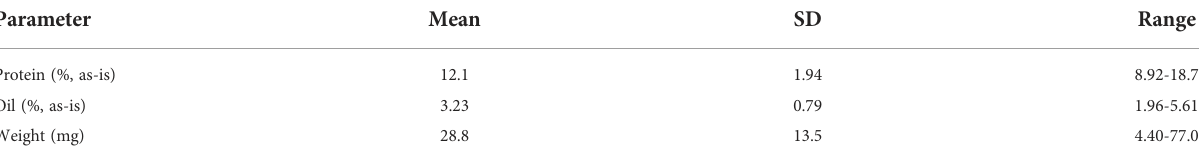
TABLE 2 Reference protein, oil, and weight of 108 single sorghum